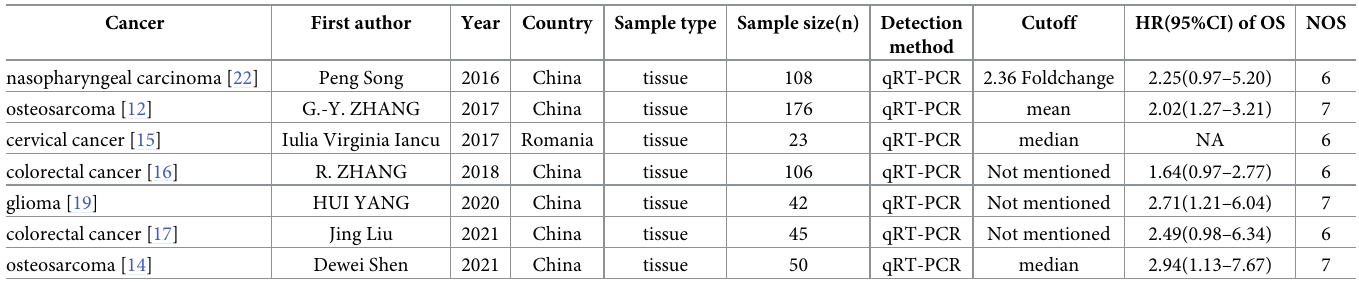
Table 1. Main characteristics of the included